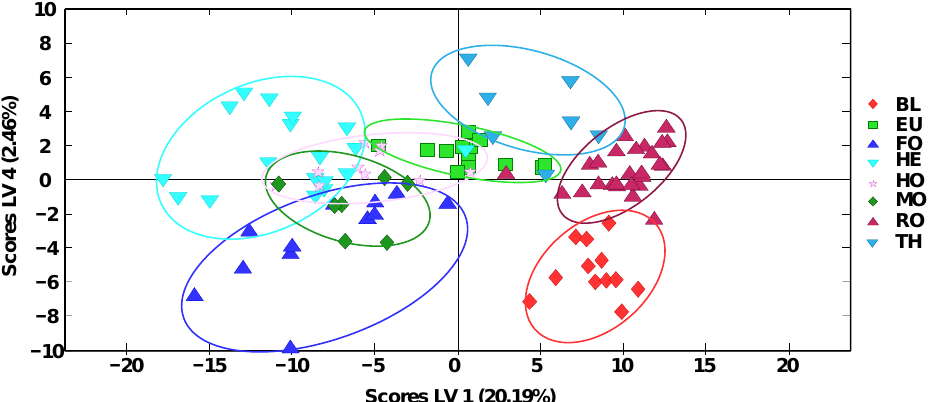
Figure 3. Partial least squares-discriminant analysis (PLS-DA) score plot of LV2 vs. LV4 when using off-line SPE HPLC-LRMS fingerprints as honey chemical descriptors (4 LVs were employed to build the model). BL: Orange/lemon blossom; EU: Eucalyptus; FO: Forest; HE: Heather; HO: Holm oak; MO: Mountain; RO: Rosemary; TH: Thyme.